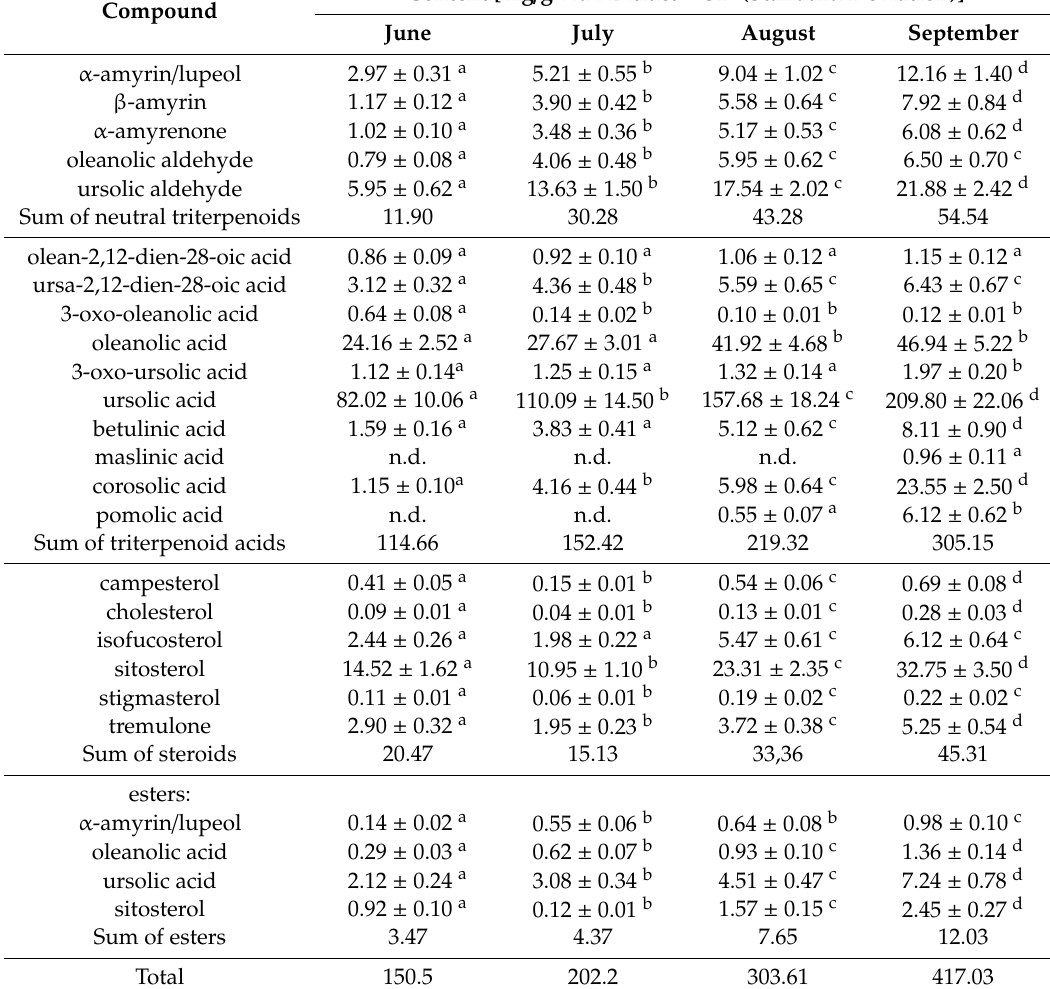
Table 1. Content of triterpenoids in cuticular waxes during rugosa rose ( Rosa rugosa ) fruit development (very young fruit harvested in June, young fruit in July, fully developed but not ripened fruit in August and ripened fruit in